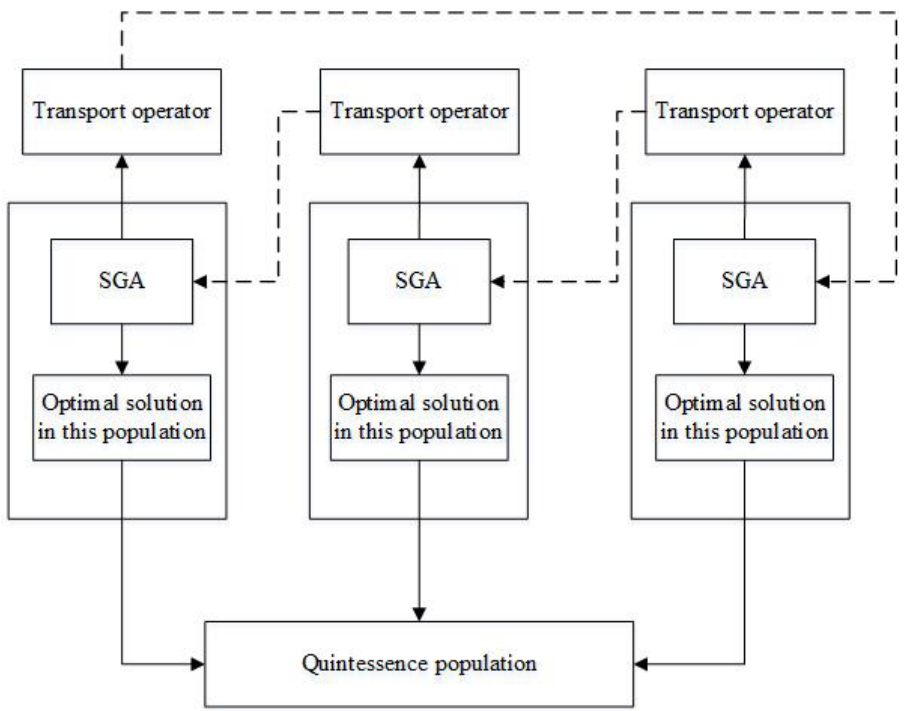
Figure 2. Multi-population genetic algorithm structure diagram. Standard genetic algorithm: